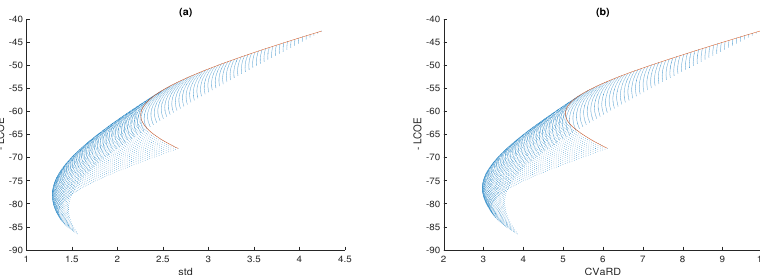
Figure 2. Power portfolio opportunity sets under the stochastic LCOE metric. The 30-year plant lifetime scenario: ( a ) the standard deviation case; ( b ) the CVaRD case. In the y -axis, LCOE stands for expected LCOE. Continuous red lines depict two-asset, gas and coal, portfolio opportunity sets.